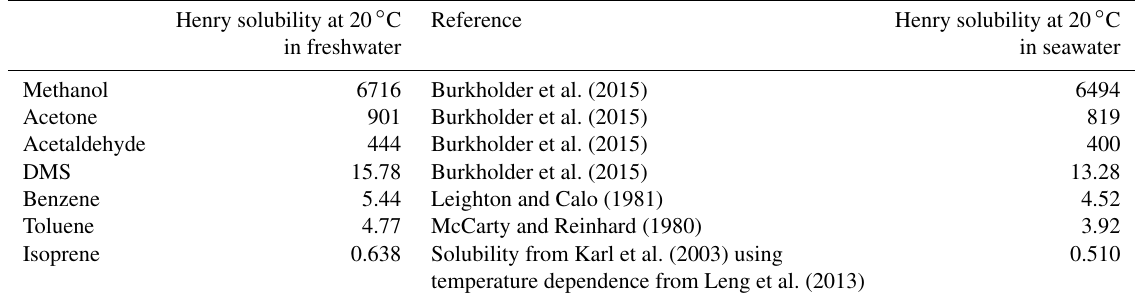
Table 1. Dimensionless Henry solubility values (water over gas) in freshwater and seawater used to compute dissolved gas concentrations. Henry solubility at 20 ◦